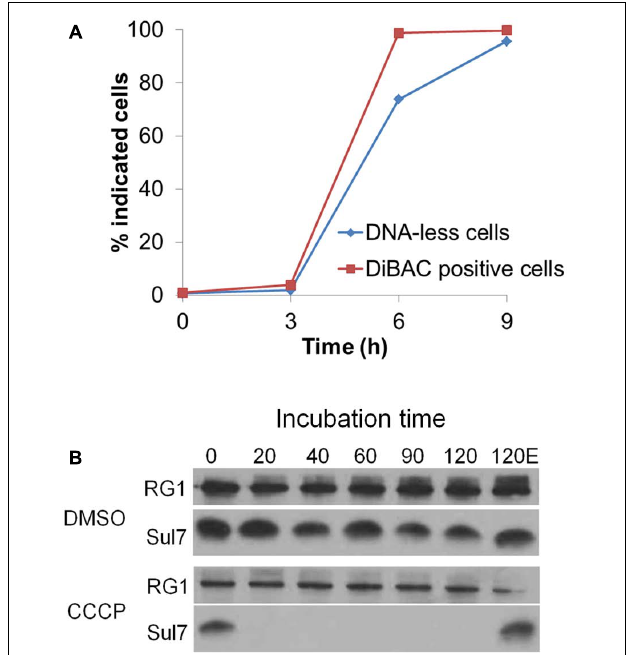
FIGURE 5 | Proton uncoupler mediated membrane depolarization and chromosome degradation. (A) The cells treated with CCCP were taken at indicated time points, stained with DiBAC4 and EB/mithramycinA, respectively, and analyzed with flow cytometry. The percentage of DNA-less cells and DiBAC-positive cells was quantified. The data are the representatives of three independent experiments. (B) The cell extracts were prepared after 6 h DMSO or CCCP treatment. Then, the cell extracts were incubated at 75 ◦ C for 120 min, during which levels of Sul7 from 20 µ g of total protein was monitored by western blot. “120E” represents the sample supplemented with EDTA and incubated at 75 ◦ C for 120